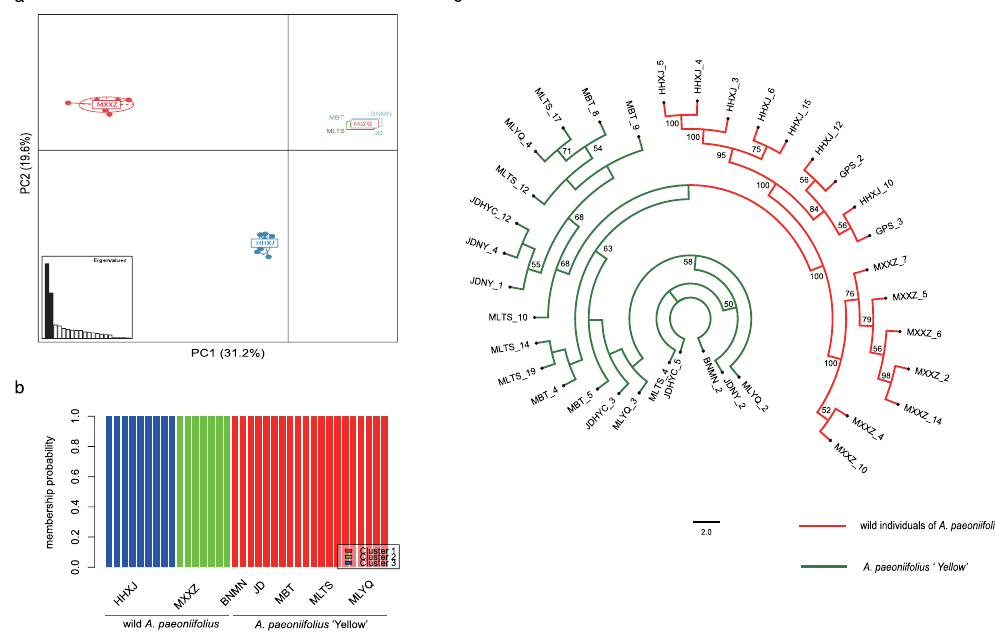
Figure 3. Genome-wide SNP-based genetic structure and phylogeny of wild and cultivated A. paeoniifolius . ( a ) Plot of first two dimensions of PCA. ( b ) Bar plot of three clusters identified with R adegenet package. ( c ) Maximum Likelihood phylogram illustrating genetic relationships among 36 individuals. All bootstrap values greater than or equal to 50% are shown.